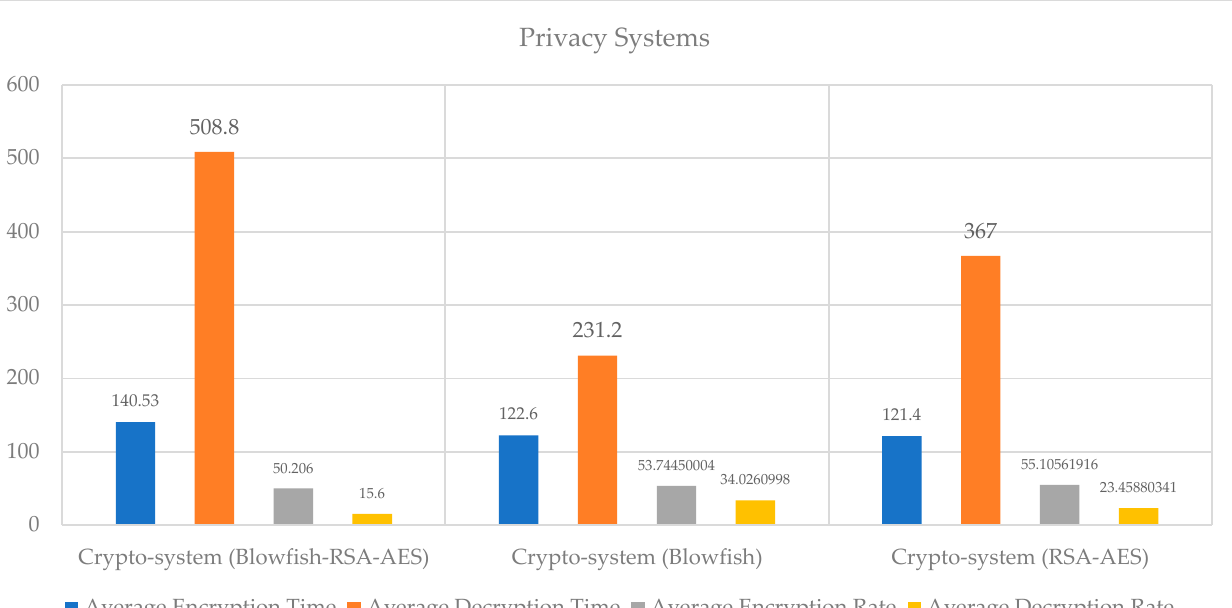
Figure 7. Performance analysis of the privacy preservation strategy.